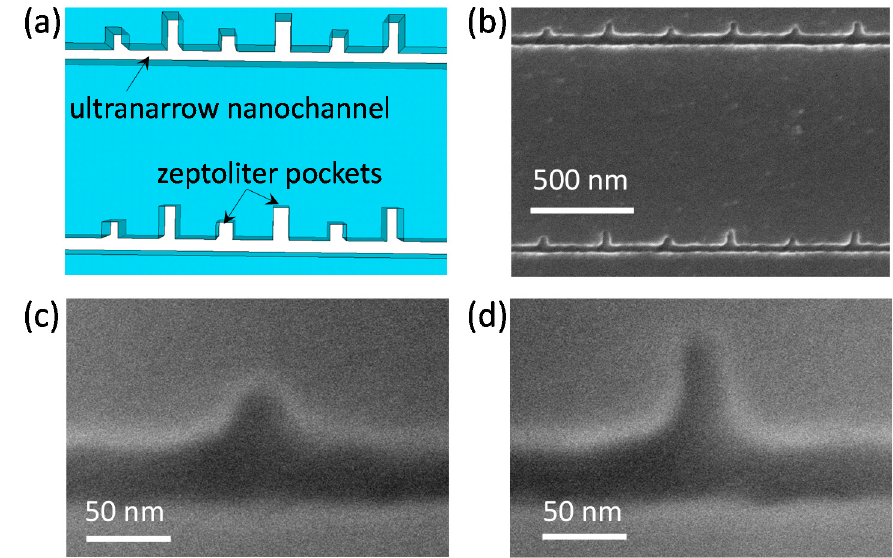
Figure 5. ( a ) Schematic and ( b ) SEM images of ultranarrow nanochannels with zeptoliter (zL, 10 − 21 L) pockets. SEM images of nanochannels with ultrasmall ( c ) square pocket and ( d ) rectangular pocket at a large magnification of 200,000×.